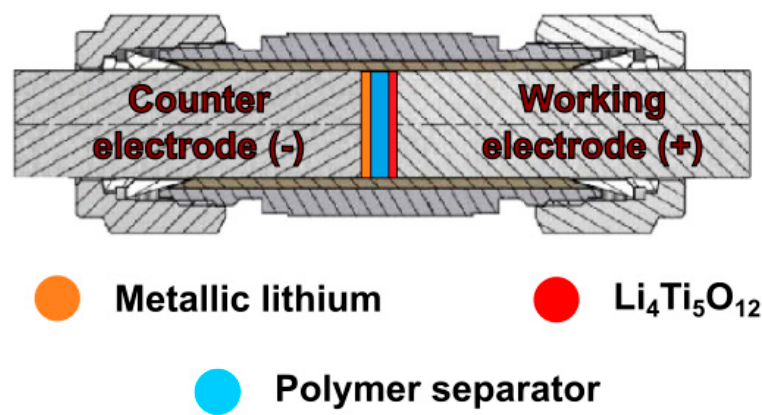
Figure 4. Schematic representation of lithium-ion cell in Swagelok ® system.